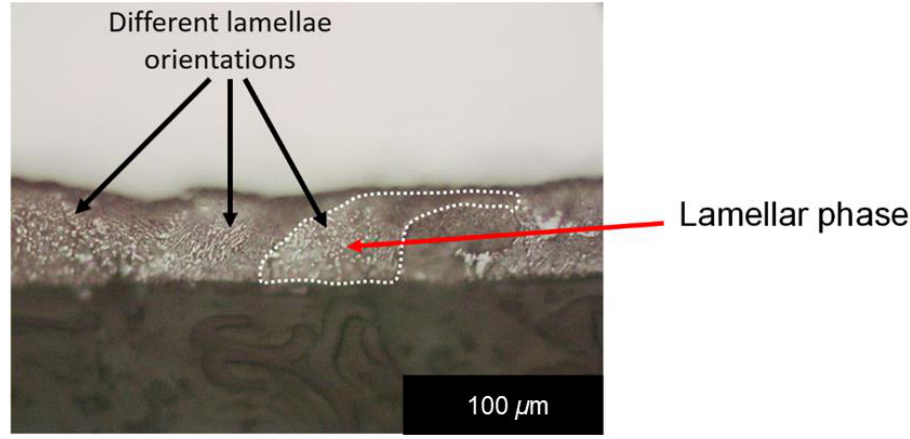
Figure 11. Microstructure of coatings obtained from Zn-Al 5%.